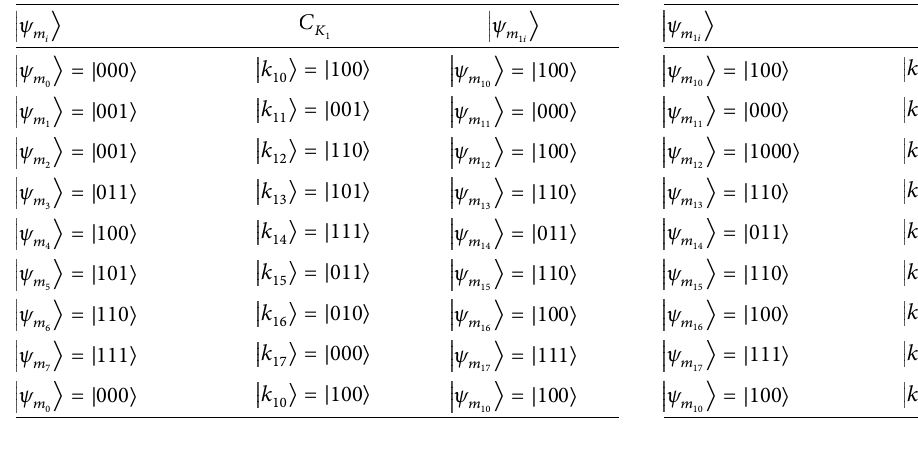
Figure 3: Block diagram of the proposed algorithm. Table 1: Controlled-NOT operations. Table 2: Hadamard